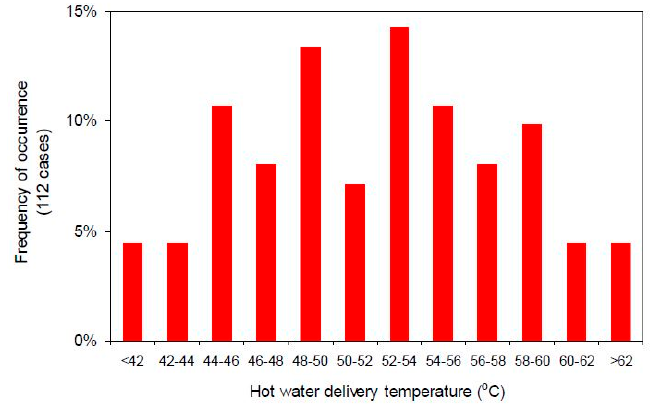
Figure 5. Temperature distribution of all usage in a conventional dwelling [14].